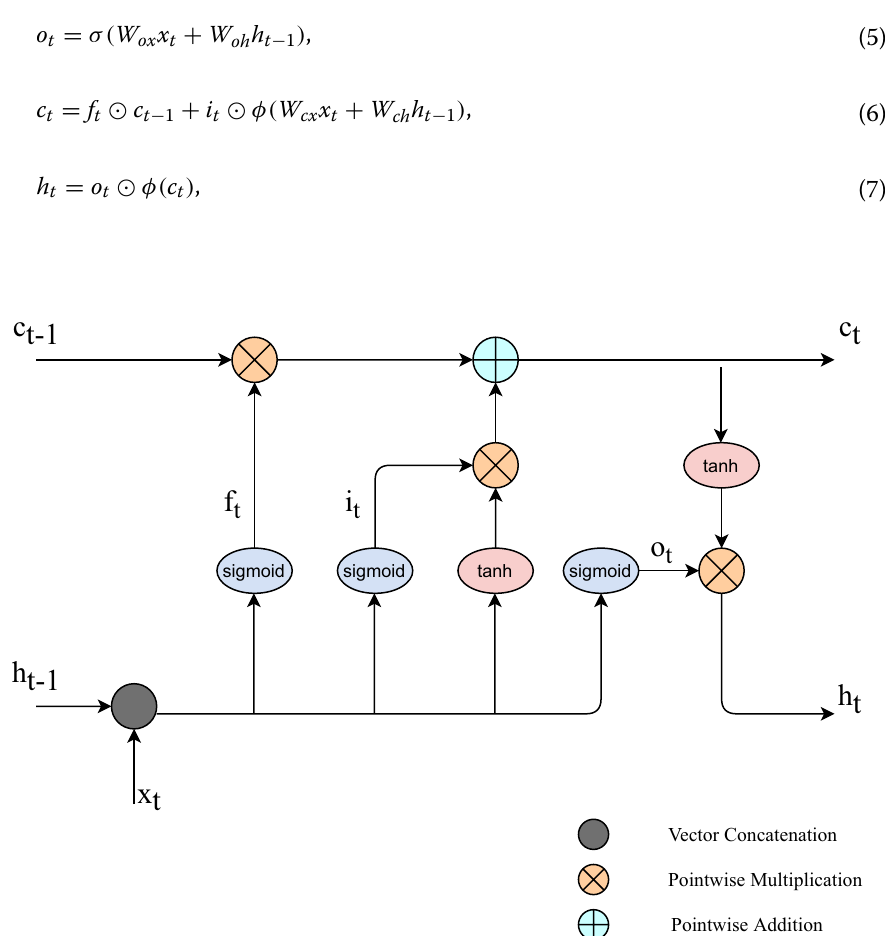
Fig. 5 LSTM architectural